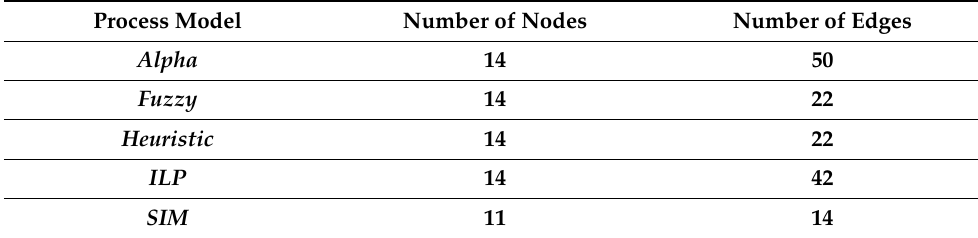
Figure A3. Process model generated by the Heuristic plugin. The box containing the symbol “#” indicates the entry point of the model, while the “$” box represents the ending (final) action of the model. Table A1. Quantitative comparison of process